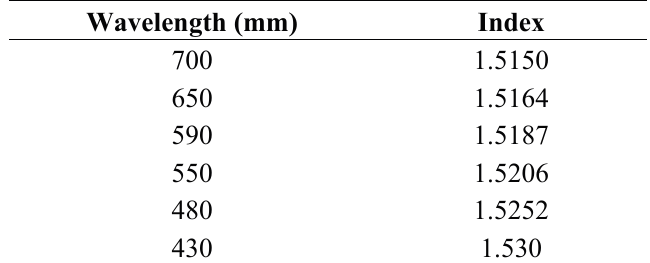
Figure 8. Liquid lens model. Table 4. Index of refraction of the glass versus